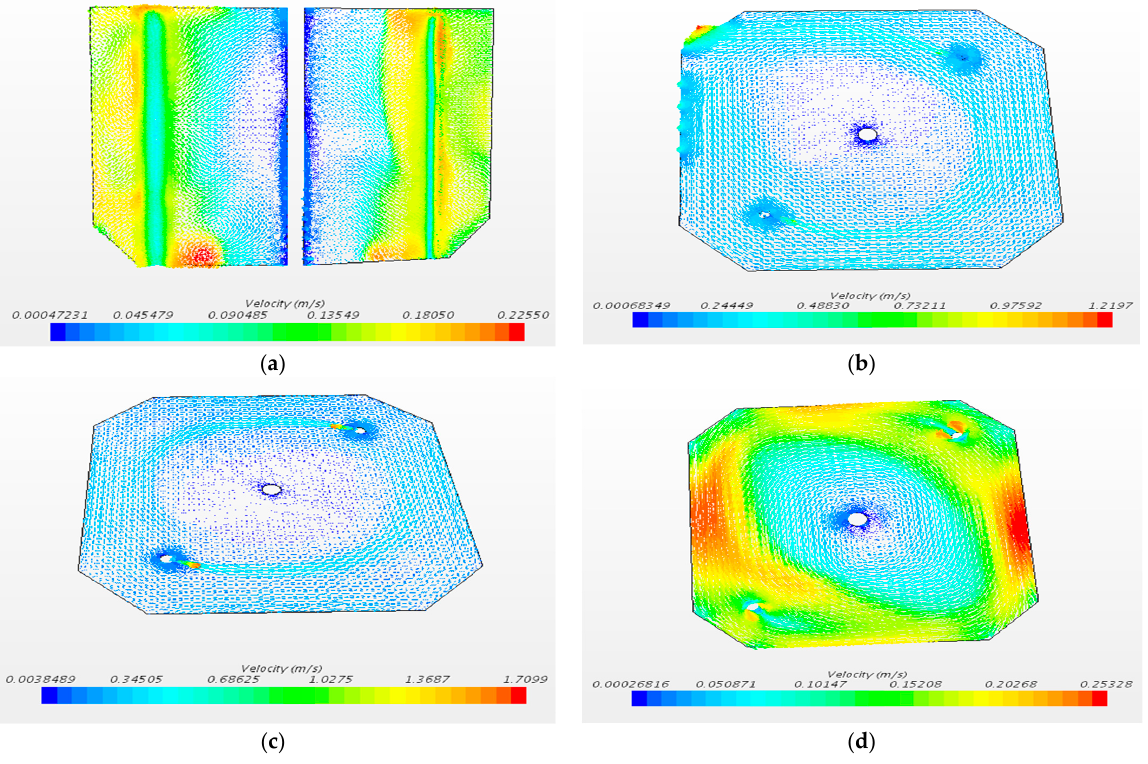
Figure 19. ( a ) middle longitudinal section, ( b ) H = 16.5 m cross section, ( c ) H = 8.5 m cross section, ( d ) H = 1.5 m cross section. (4) Bottom outflow ratio of 10%